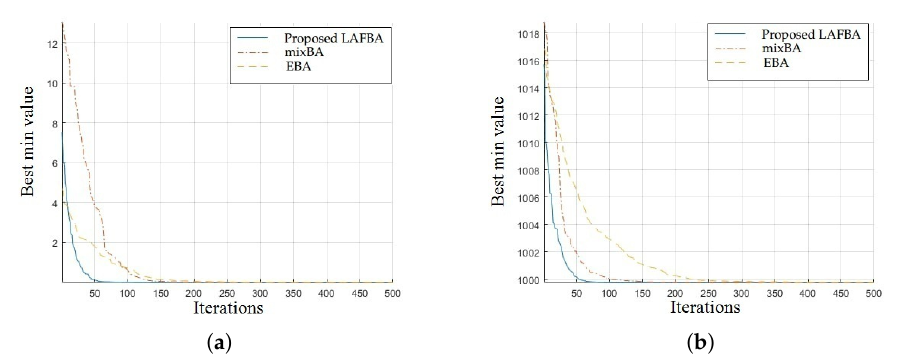
Figure 8. ( a ) Alpine function convergence graph. ( b ) Bent-cigar function convergence graph. Alpine (o) and Bent- cigar (p) convergence graphs showed that the proposed algorithm performed better than the other algorithms and proved its effectiveness in terms of finding global optima and increasing convergence speed.